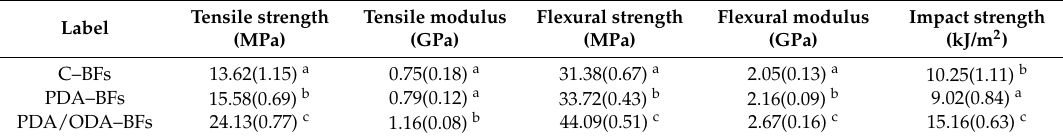
Table 5. Static Mechanical Properties Statistics of the BFs reinforced PBS